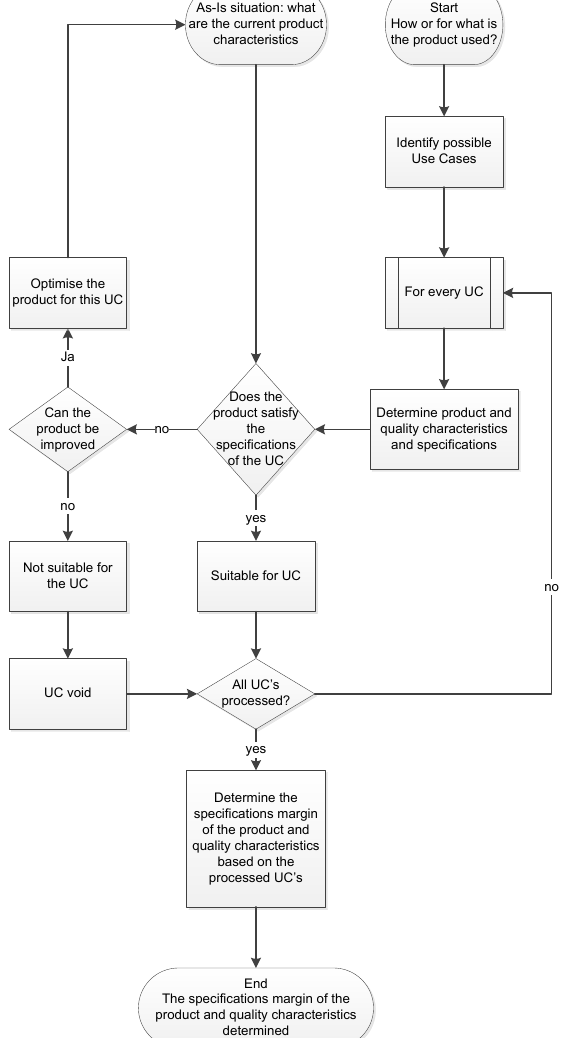
Figure 2: process flow of identifying customer product and quality requirements for producer